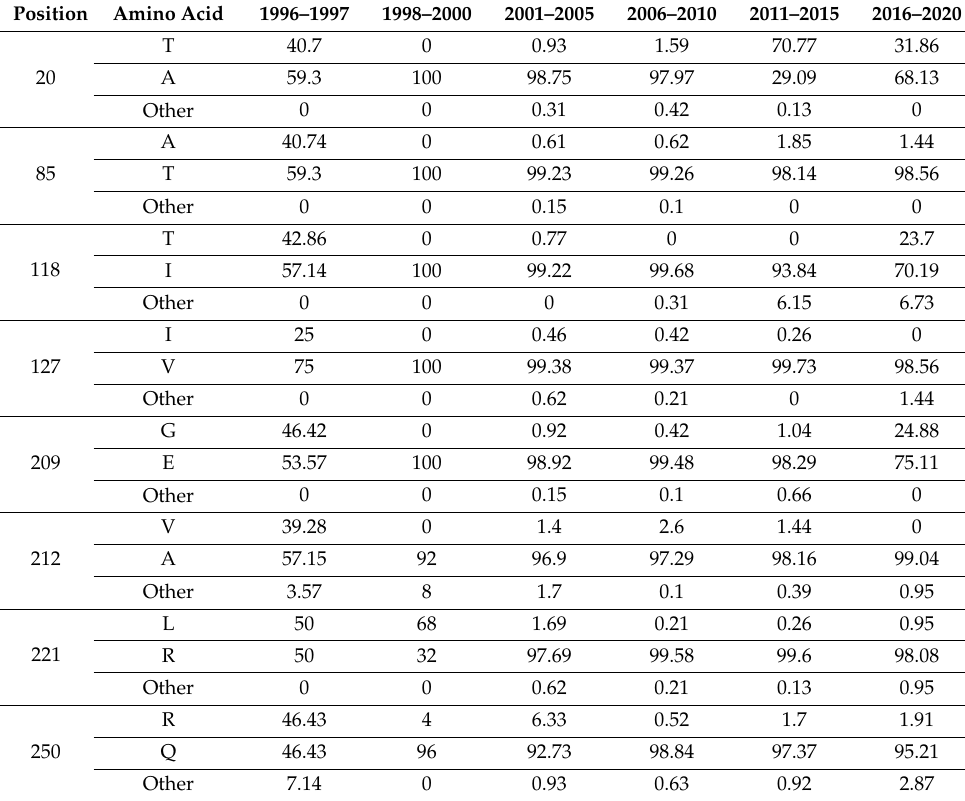
Table 1. Amino acid changes in PA-X proteins from H5N1 IAV isolated in avian. Position Amino